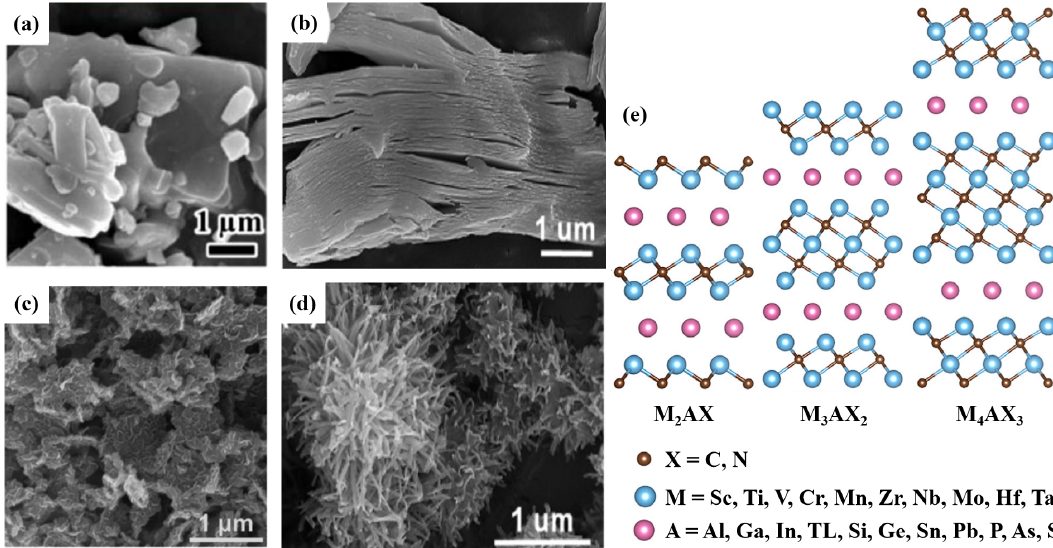
Figure 12. ( a ) SEM image of Ti 3 AlC 2 particle before treatment. Reproduced with permission from reference [183]. Copyright 2018, Elsevier. ( b ) SEM image of Ti 3 C 2 MXene. Reproduced with permission from reference [184]. Copyright 2017, Wiley-VCH. ( c ) SEM image of MoS 2 /Ti 3 C 2 -MXene@C nanohybrids. Reproduced with permission from reference [185]. Copyright 2017, Royal Society of Chemistry. ( d ) Ti 3 C 2 -TiO 2 nanoflowers synthesized at 300 ◦ C temperature. Reproduced with permission from reference [184]. Copyright 2017,